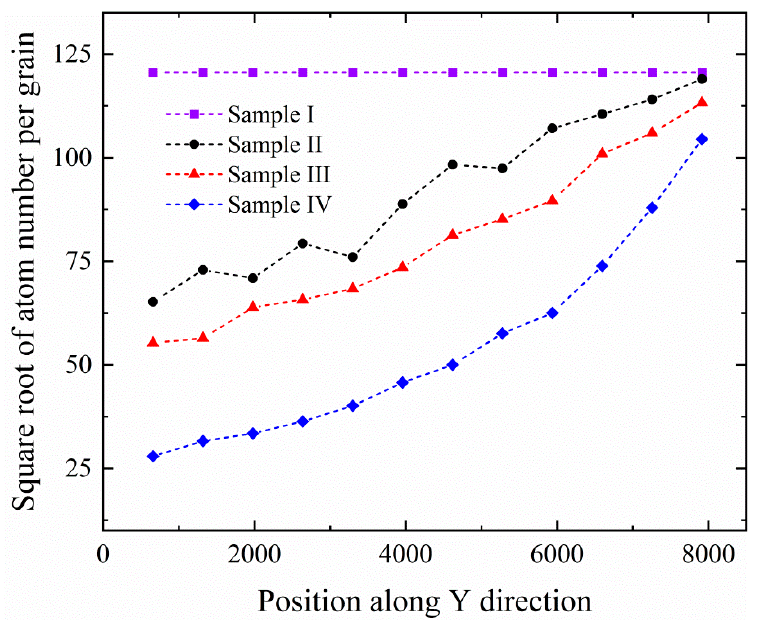
Figure 11. The square root of atomic number per grain as the measure of grain size along the supergravity direction after the solidification in sample I–IV. The grain size is spatially uniform with no graded structure in sample I, so that the global average grain size is calculated as a reference.